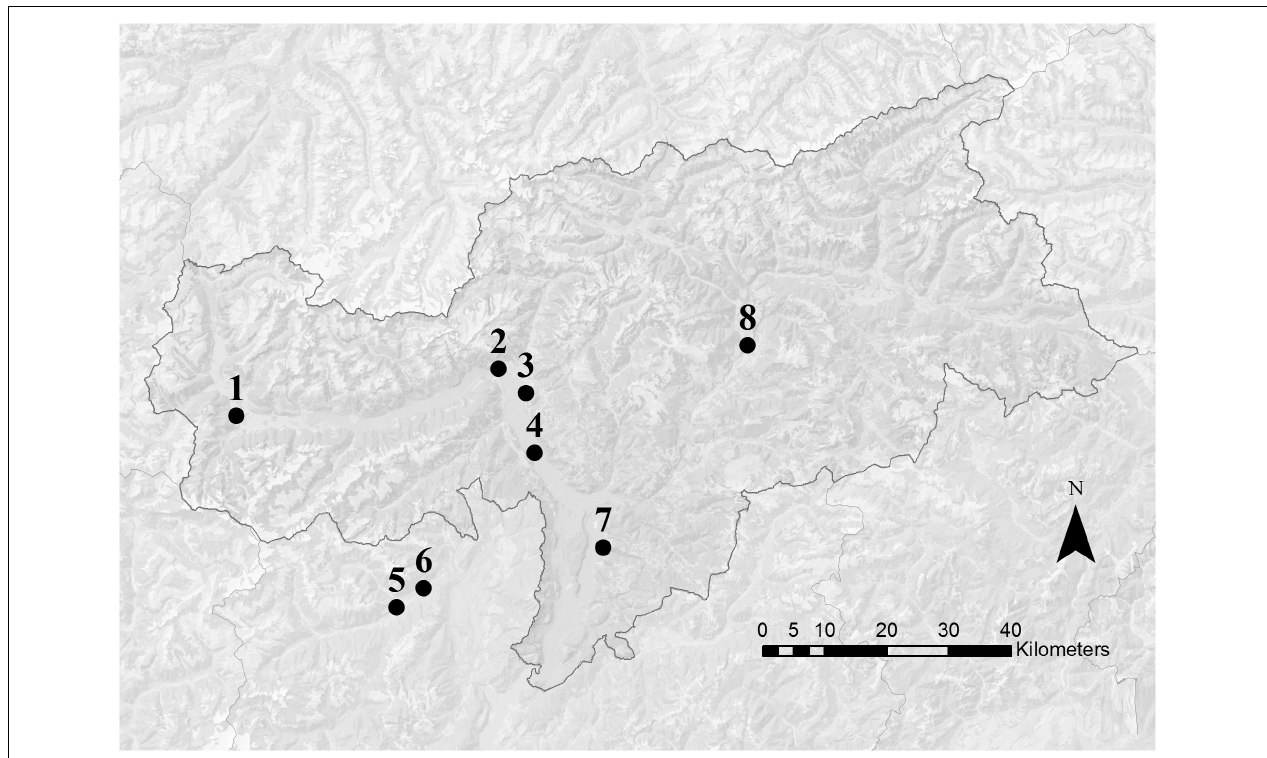
FIGURE 1 | Map of South Tyrol (Italy). Dots indicate the approximate position of the apiary locations. Numbers refer to the information reported in Table 1 . Apiaries 5 and 6 were located in the nearby Trento province.